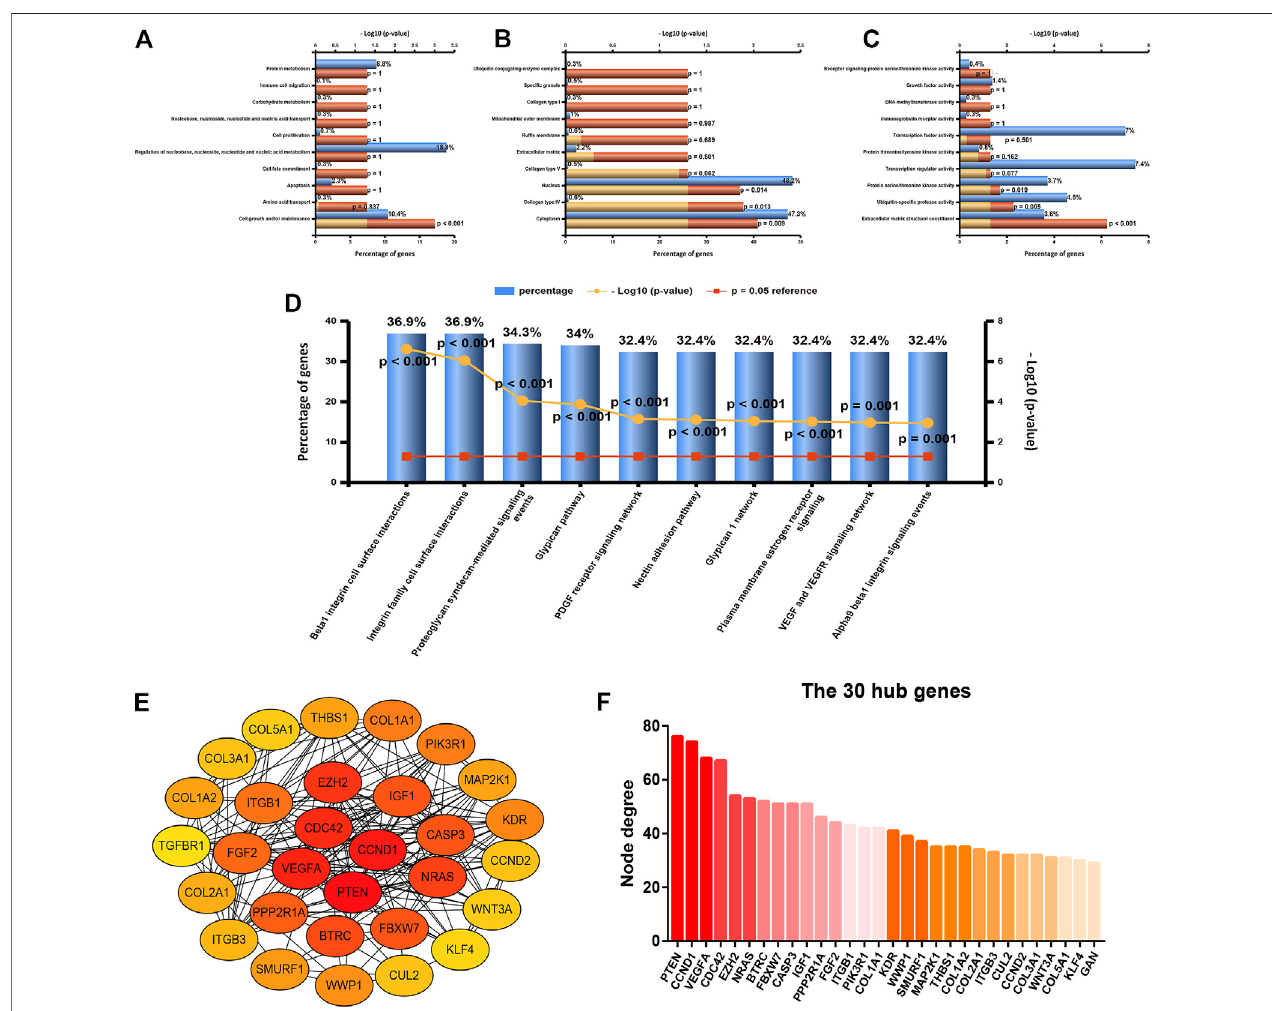
FIGURE 4 | Enrichment analysis and protein – protein interaction (PPI) network analysis for the target genes of fi ve miRNAs (let-7b-5p, miR-195-5p, miR-29a-3p, miR-26a-5p, and miR-26b-5p). (A) Top 10enriched biologicalprocess (BP) items analyzed byFunRich. (B) Top 10enriched cellular component (CC) items analyzed by FunRich. (C) Top 10 enriched molecular function (MF) items analyzed by FunRich. (D) Top 10 enriched biological pathway items analyzed by FunRich. (E) PPI sub- network of top 30 hub genes according to node degree. (F) Top 30 hub genes ranked by node